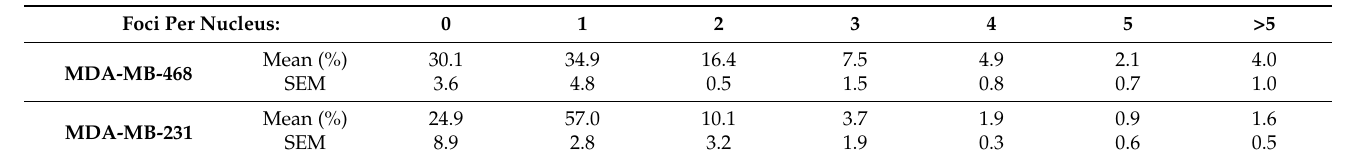
Table 2. The distribution of breast cancer cells bearing the indicated endogenous γH2AX foci in their nuclei printed at 532 nm wavelength.